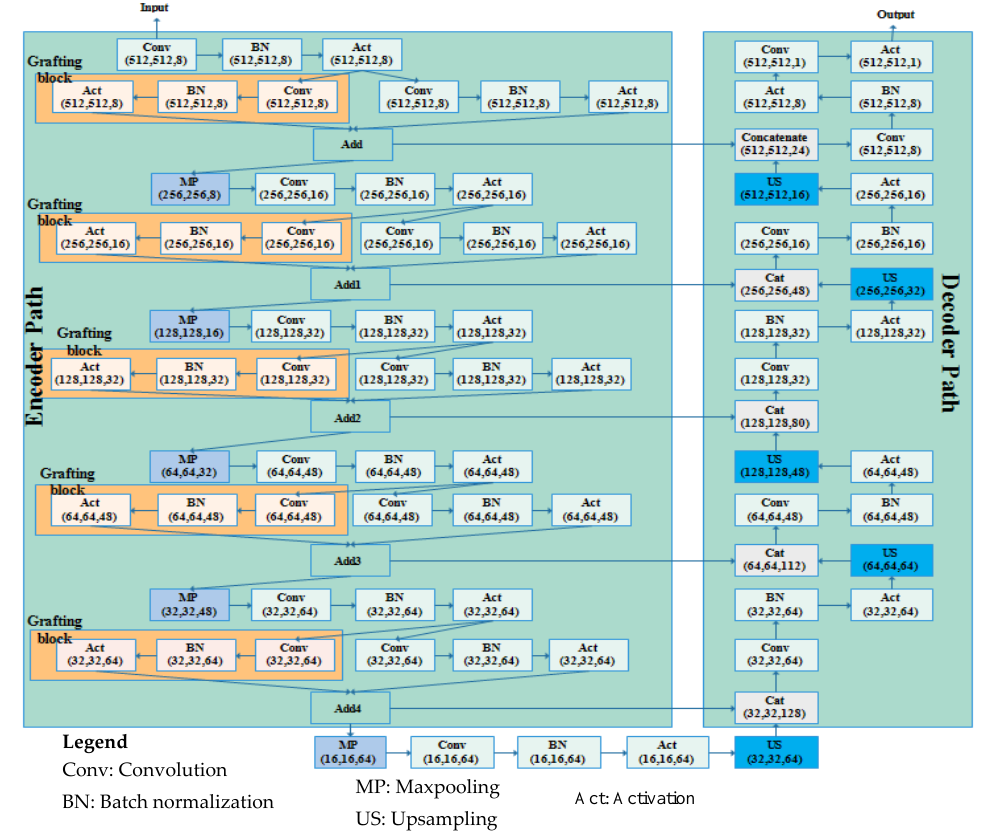
Figure 3. The architecture of the Graft-U-Net model.